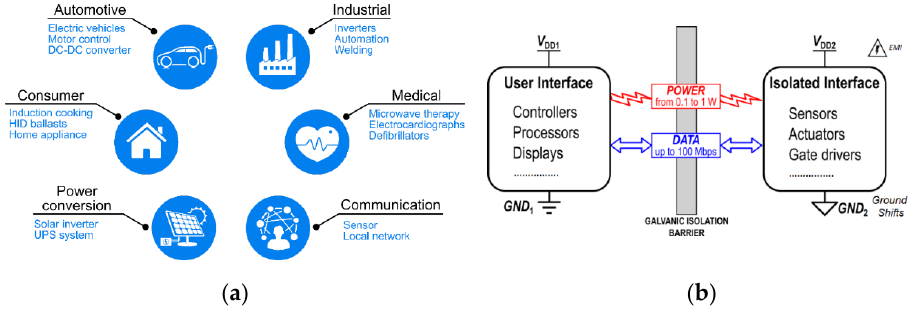
Figure 1. ( a ) Galvanic isolation application fields; ( b ) simplified block diagram of a galvanically isolated system. Reproduced from [1]. Copyright 2019, Springer Nature Customer Service Centre GmbH.